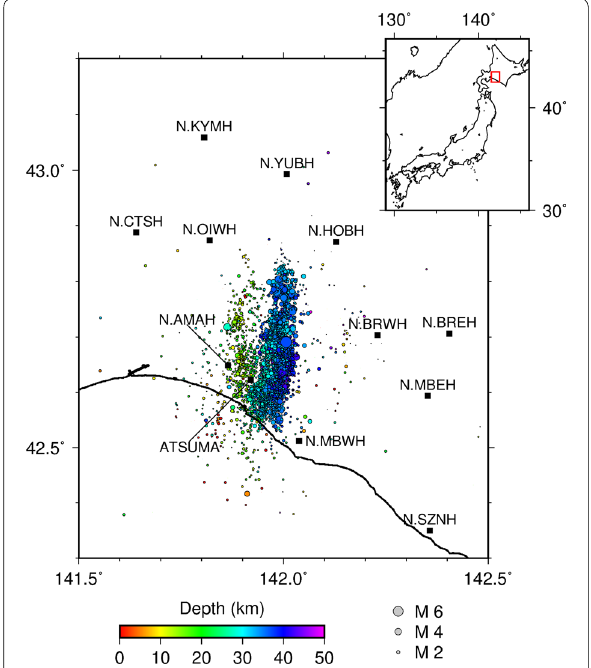
Fig. 1 Locations of seismic stations used in this study, and the seismicity from September 1 to October 31, 2018. The inset map shows the location of the study